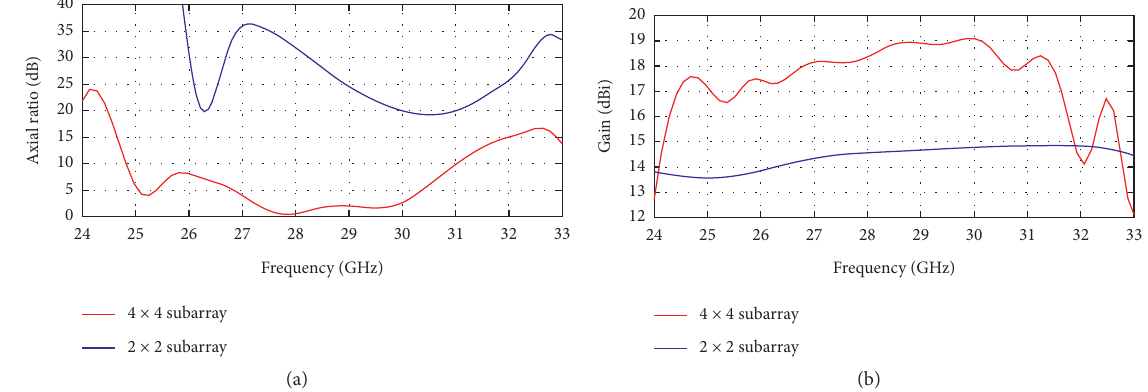
Figure 7: Simulated (a) AR and (b) gain of 2 × 2 and 4 × 4 subarrays.